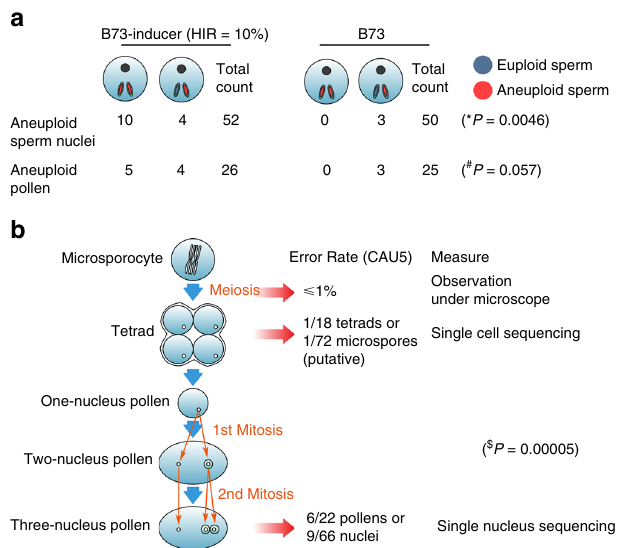
Fig. 3 Chromosomal fragment deletions in different pollen developmental stages. a The number of aneuploid sperm and pollen for B73 and the B73- inducer line. b The degree of chromosome fragmentation (in CAU5) was estimated in meiotic and mitotic stage by single cell and nucleus sequencing and observation under microscope. ∗ χ 2 test, P represents the difference of aneuploid frequency of B73-inducer sperms (14/52) and B73 sperms (3/50). # χ 2 test, P represents the signi fi cant difference of aneuploid frequency of B73-inducer pollens (9/26) and B73 pollens (3/25). $ χ 2 test, P represents the difference of aneuploid frequency of CAU5 pollens (6/22) and CAU5 microspores